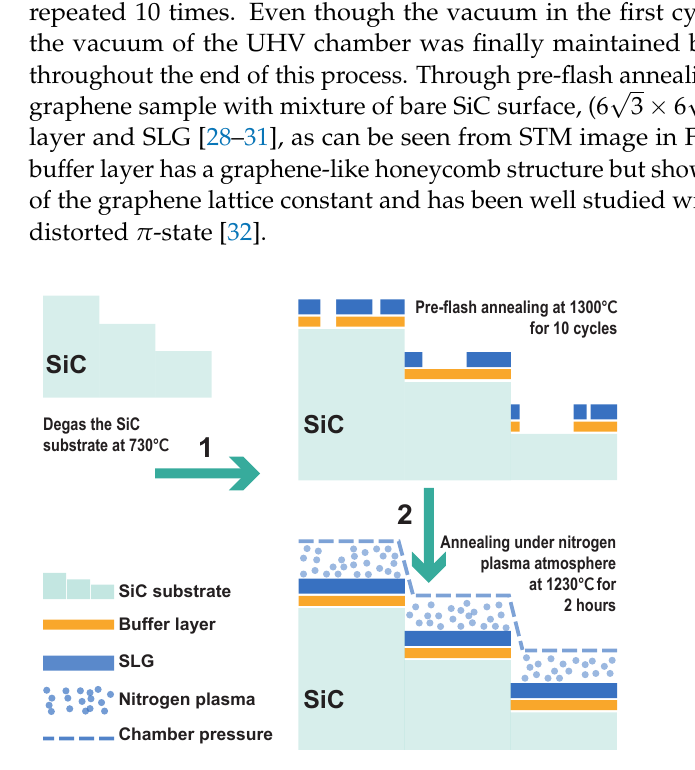
Figure 1. Schematic diagram of preparing uniform SLG on 4H-SiC(0001). The figure involves three main processes: the degassing of the substrate, pre-flash annealing, and annealing under nitrogen plasma atmosphere. The green arrows indicate the sequence of the three processes, and the lower left corner is the legend of the different lines and graphics. Among them, chamber pressure is to point out that the annealing pressure in nitrogen plasma atmosphere (1.1 × 10 − 5 mbar) is much higher than that of pre-flash